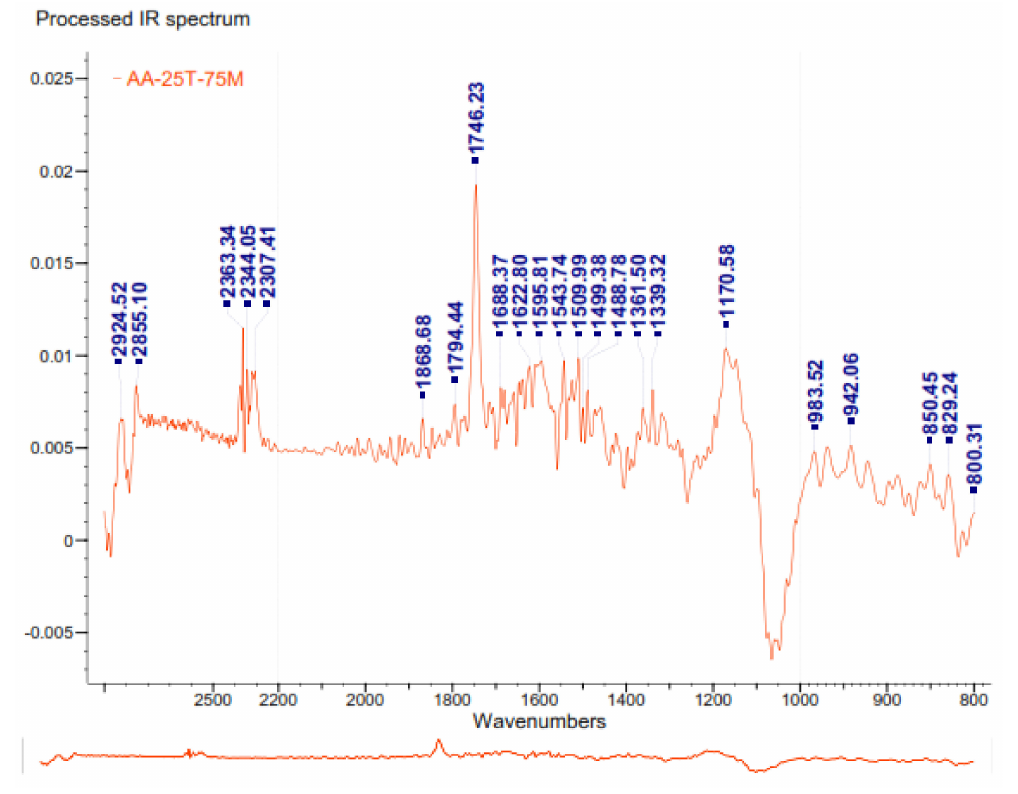
Figure A4. FTIR of sample AA-25T-75M. Table A4. Analysis of FTIR result for sample